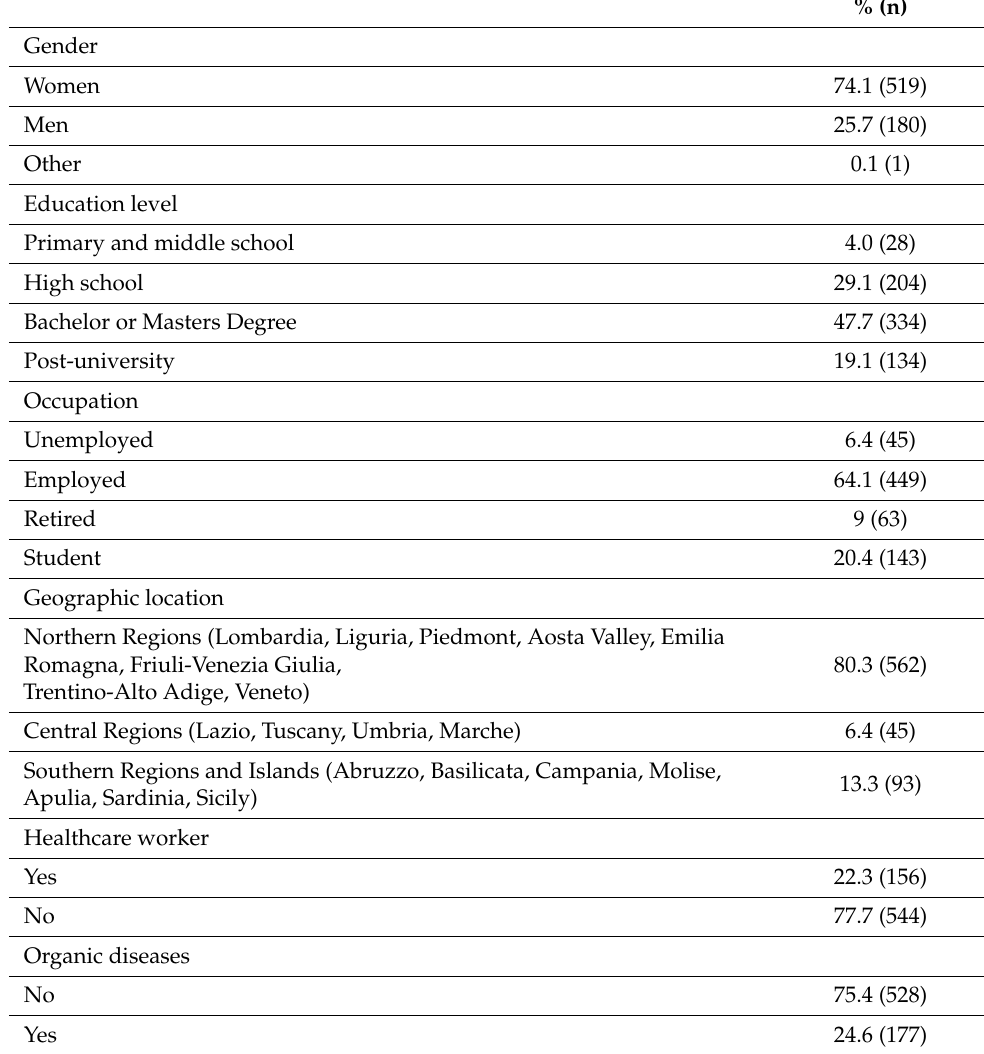
Table 1. Descriptive statistics of the sample (n =